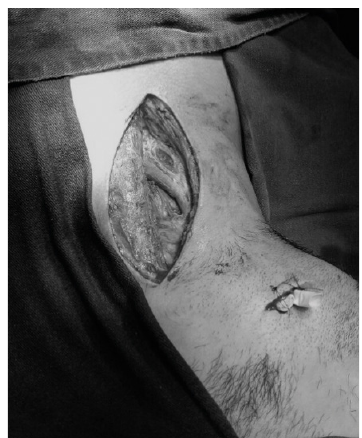
Figure 3. Transoperatory view showing the surgical wound and the poor aspect of the fascia, that appears with a pale